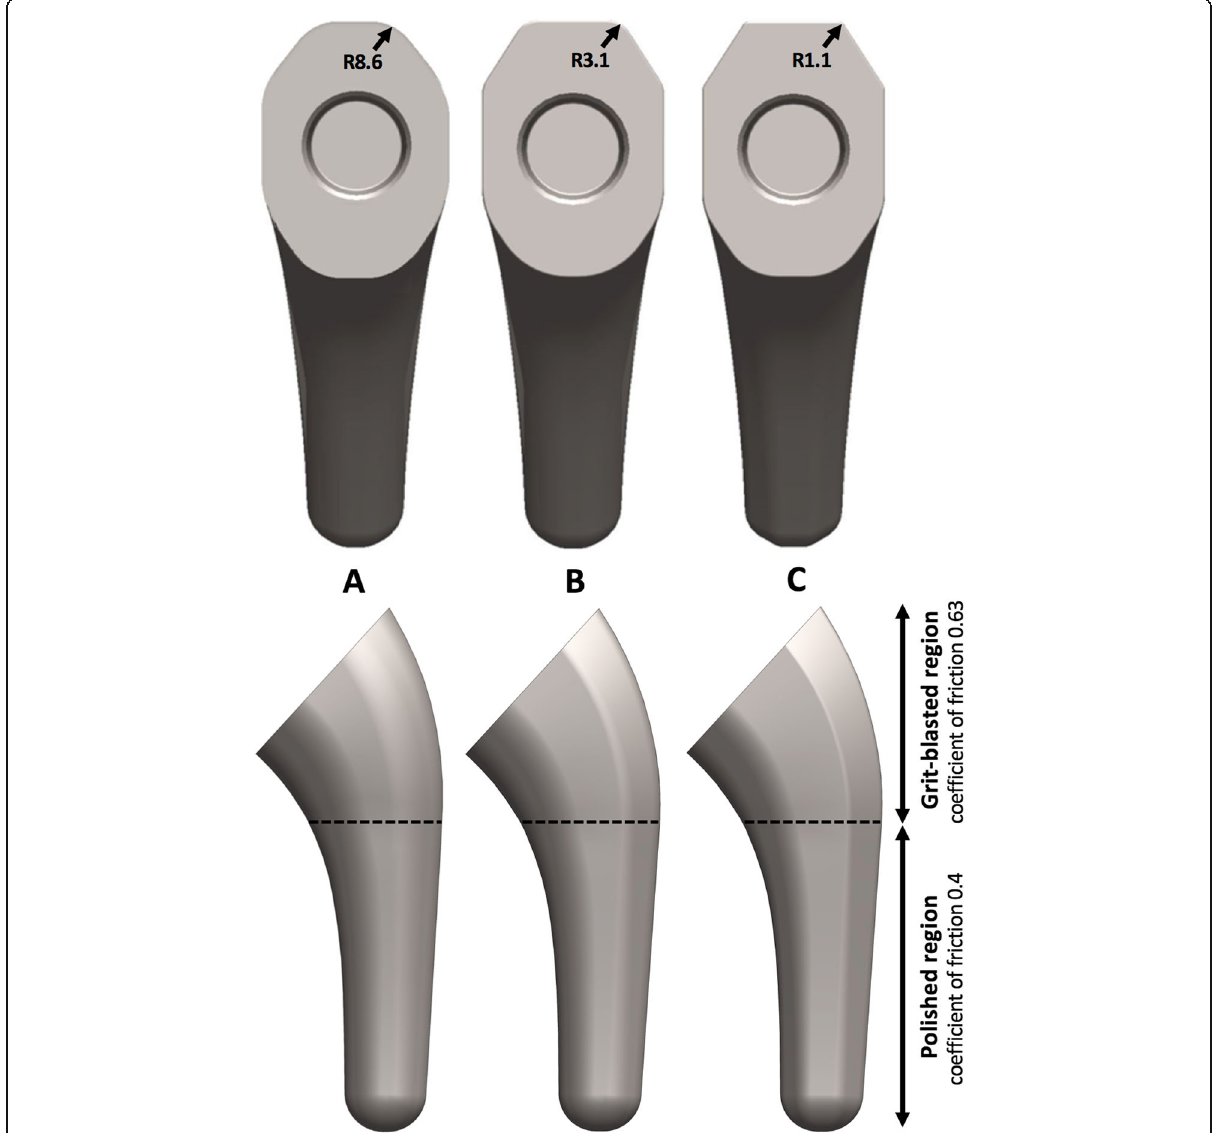
Fig. 1 Three generic models of humeral stems presenting different proximal metaphyseal geometry: predominantly oval ( a ), semi-angular ( b ), and predominantly angular ( c